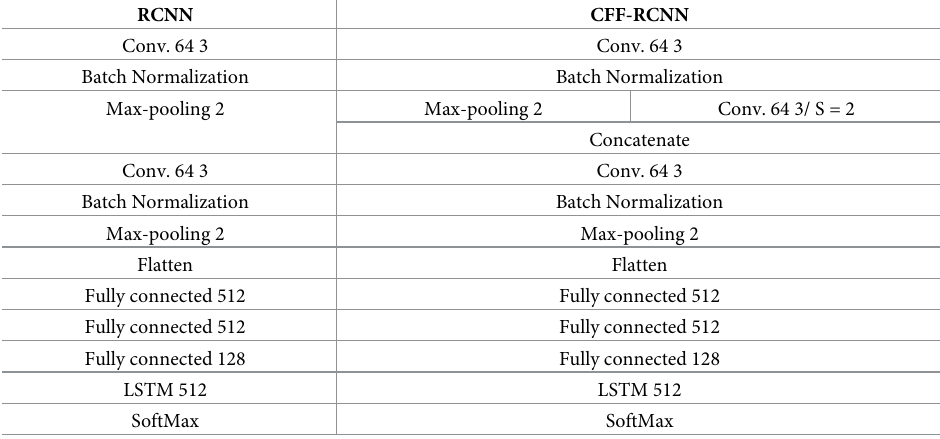
Table 1. The structure comparison between the RCNN and CFF-RCNN.